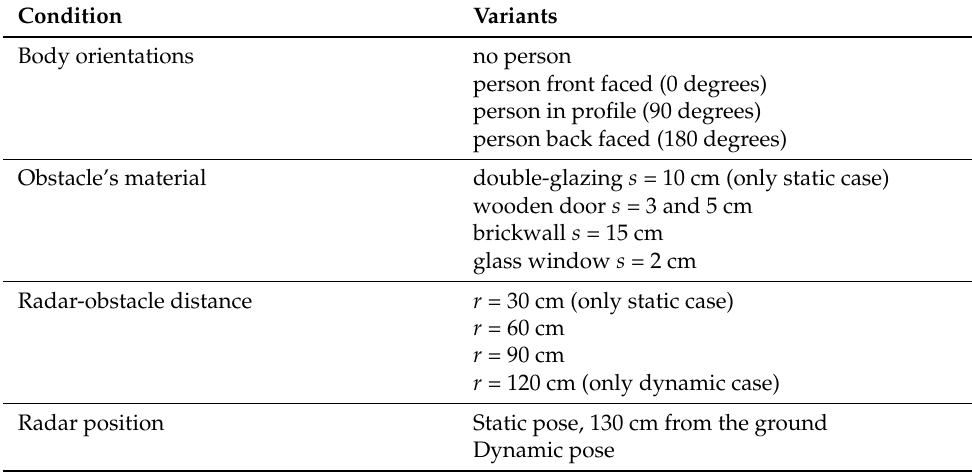
Table 1. Measurement